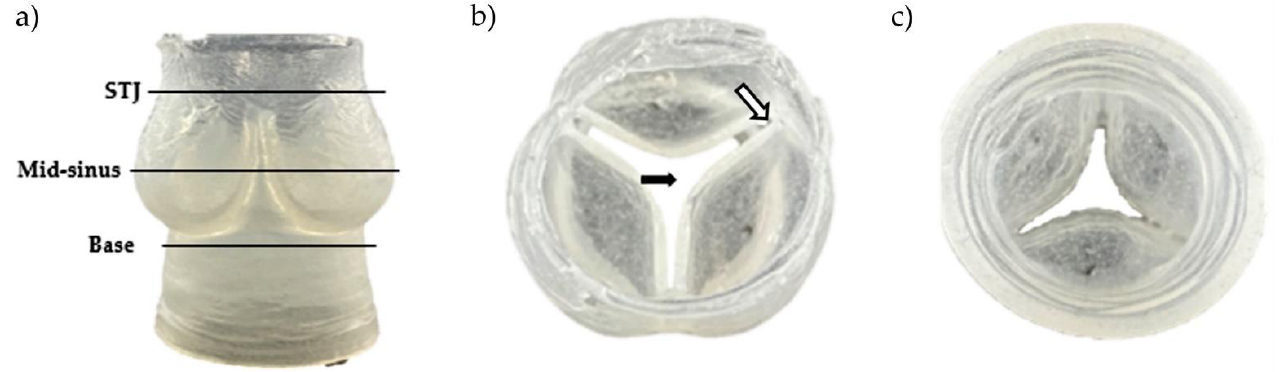
Figure 4. Resulting aortic valve scaffold made of sodium-alginate hydrogel. ( a ) Side view with three regions of interest (STJ: sino tubular junction). ( b ) Top view. The black arrow shows the opened central area, and the white arrow shows the leaflet thickness and the spacing at the commissure. ( c ) Bottom view.